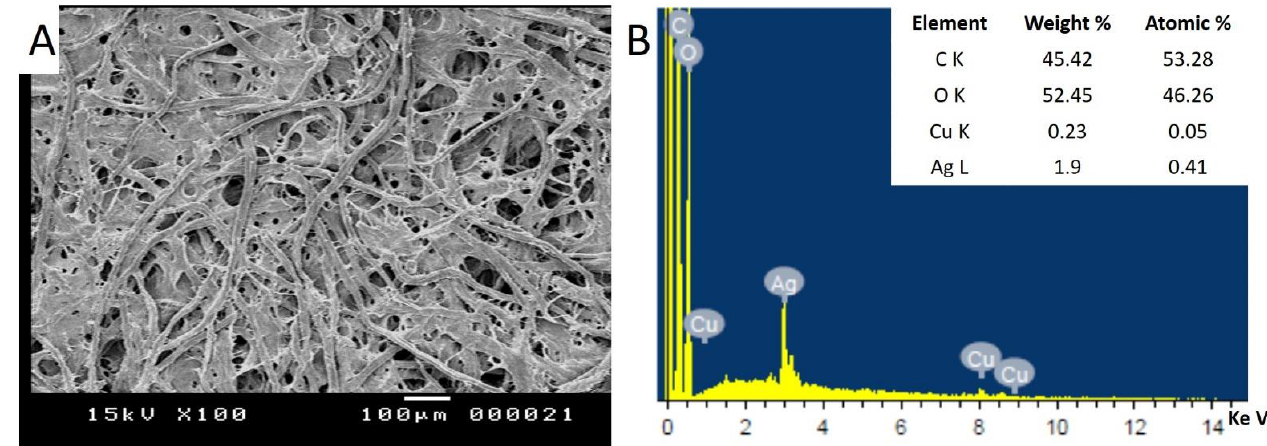
Figure 2. ( A ) SEM image of treated Whatman filter paper without microbial inoculation; ( B ) EDX profile exhibiting the chemical composition of treated filter paper.